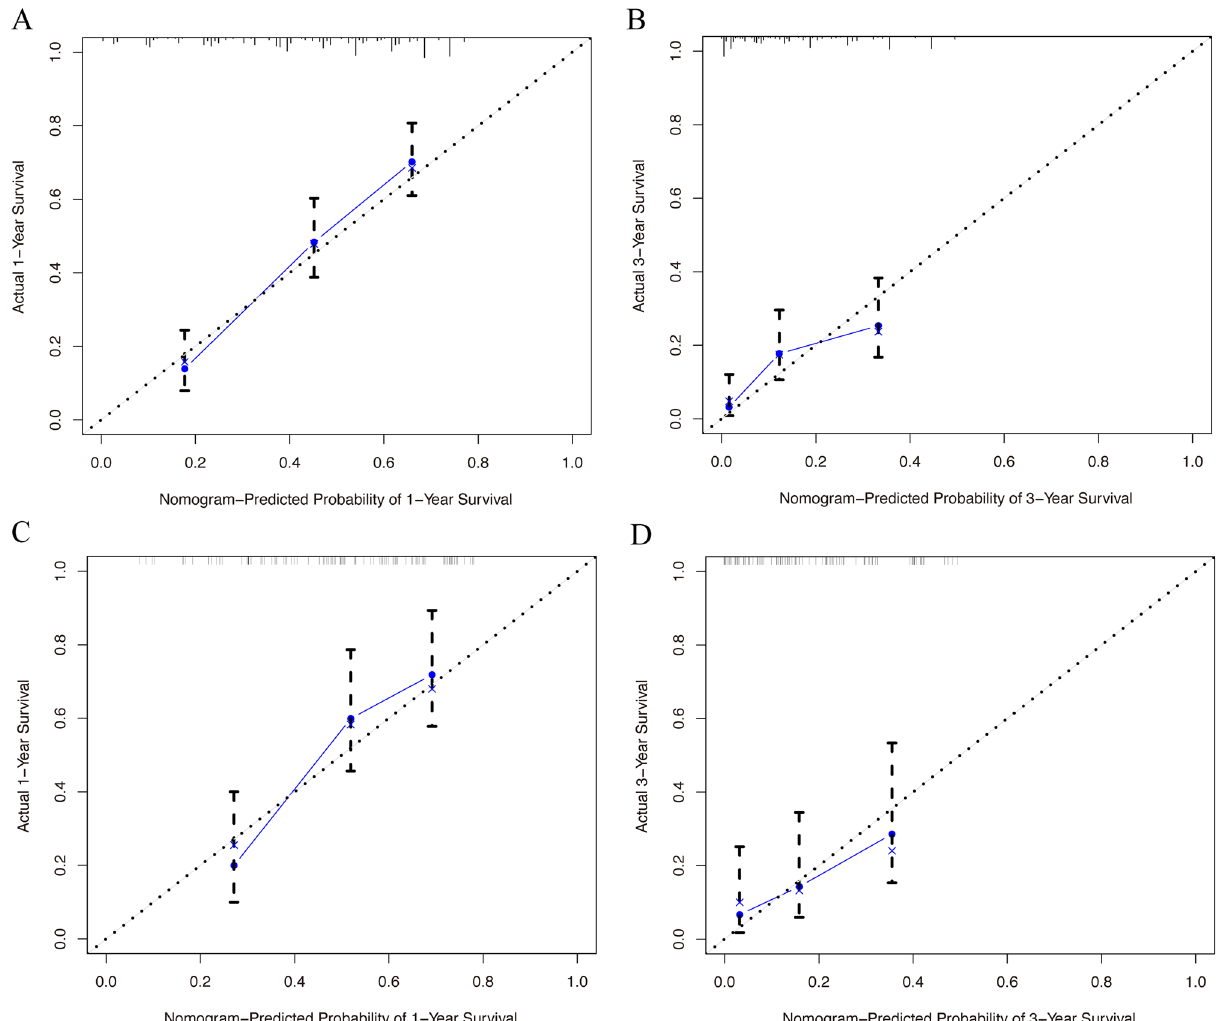
Figure 3. Calibration plot of the nomogram for 1- and 3-year OS: ( A ) at 1 year in the training set; ( B ) at 3 year in the training set; ( C ) at 1 year in the validation set; ( D ) at 3 year in the validation set. OS, overall